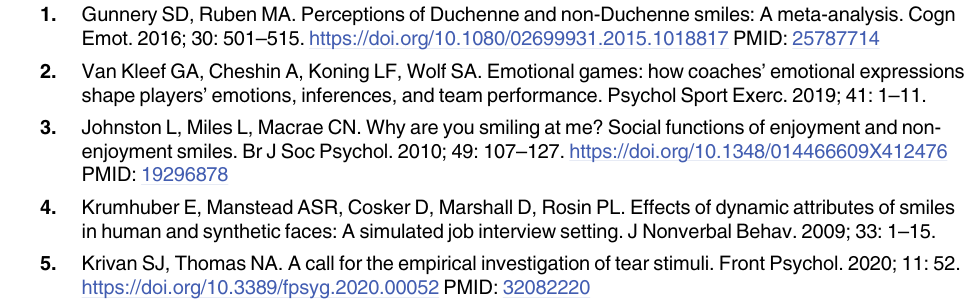
S1 Table. Results for the magnitude of difference between the perceived-as-genuine and perceived-as-posed expressions of happiness compared to ambiguous expressions. S2 Table. Results for the magnitude of difference between the perceived-as-genuine and perceived-as-posed expressions of anger compared to ambiguous